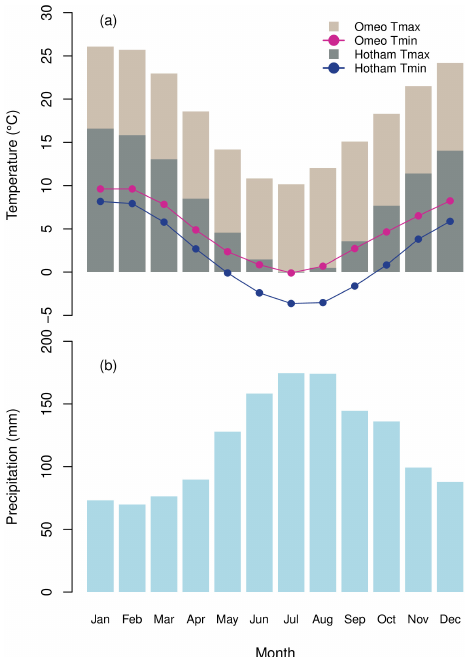
Figure 2. (a) Mean monthly maximum and minimum air temper- ature at Omeo and Mt Hotham meteorological stations. (b) Mean monthly precipitation at Harrietville meteorological